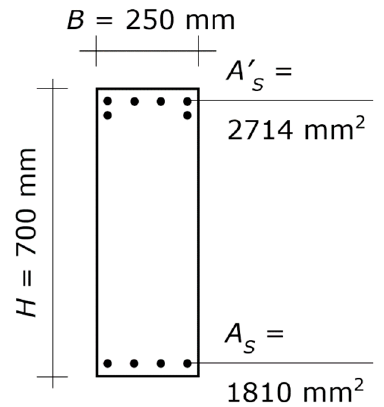
Figure 4. First application example. Cross-section of the two beams at the beam–column joint. The diagram shows the concrete section and the longitudinal steel reinforcement, while it does not show the stirrups (which play no direct role in column proportioning). The symbols are those defined in SubSection 2.1, used for the column. More specifically, B and H denote width and height of the beam, respectively, A s denotes the area of the bars at the lower edge, and A ’ s denotes the area of the bars at the upper edge.